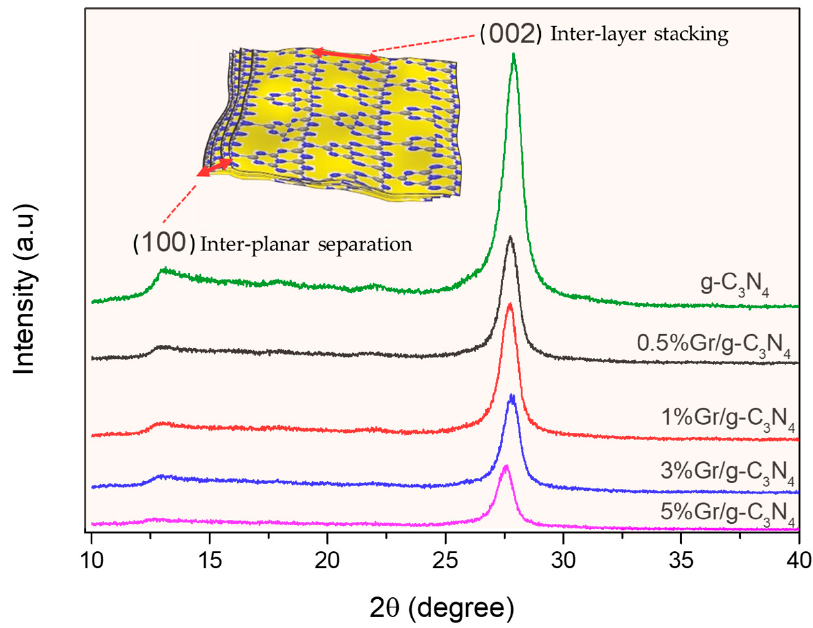
Figure 1. The XRD patterns of the Gr/g-C 3 N 4 were prepared via the thermal method (inset schematic presentation of graphene stacking between g-C 3 N 4 layers).